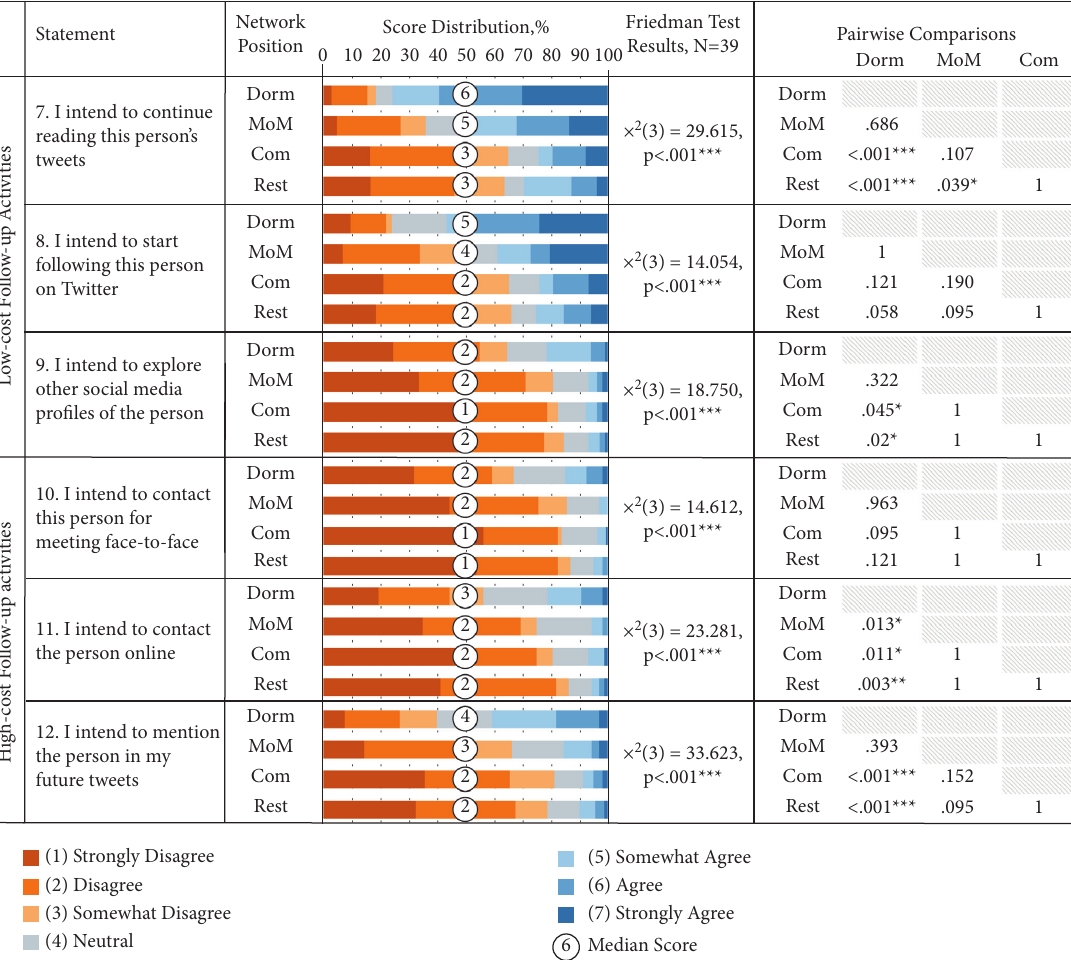
Figure 8: Proportions of given scores regarding willingness to follow-up on recommendations from each structural network position, and the results of Friedman test with details on Bonferroni corrected pairwise comparison. 72 recommendations per position. Significance codes: 0 “ ∗∗∗ ” 0.001 “ ∗∗ ” 0.01 “ ∗ ” 0.05 “”